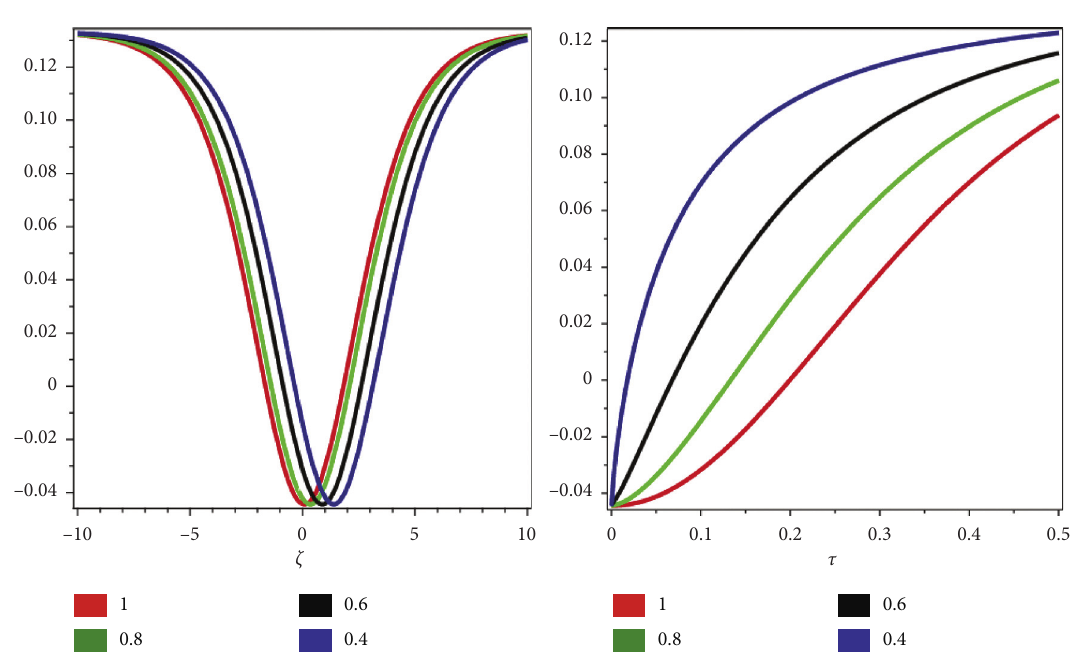
Figure 5: The fractional order ρ of Example 2 with respect to ζ and τ